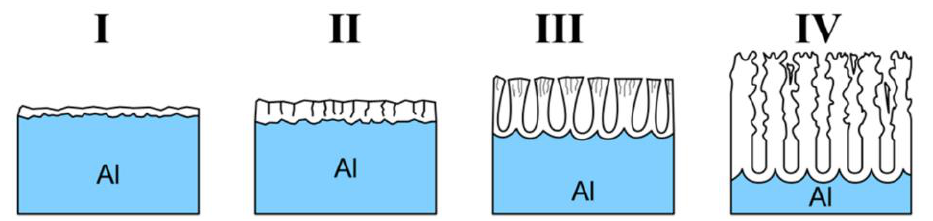
Figure 3. Scheme of step-by-step formation of porous oxide. ( I ) Formation of barrier layer, ( II ) formation of local cavities, ( III ) growth of porous structure, and ( IV ) schematic of nanoporous structure with initially disordered structure and following self-ordering. Reprinted (adapted) with permission from [49]. Copyright 2014 American Chemical Society.